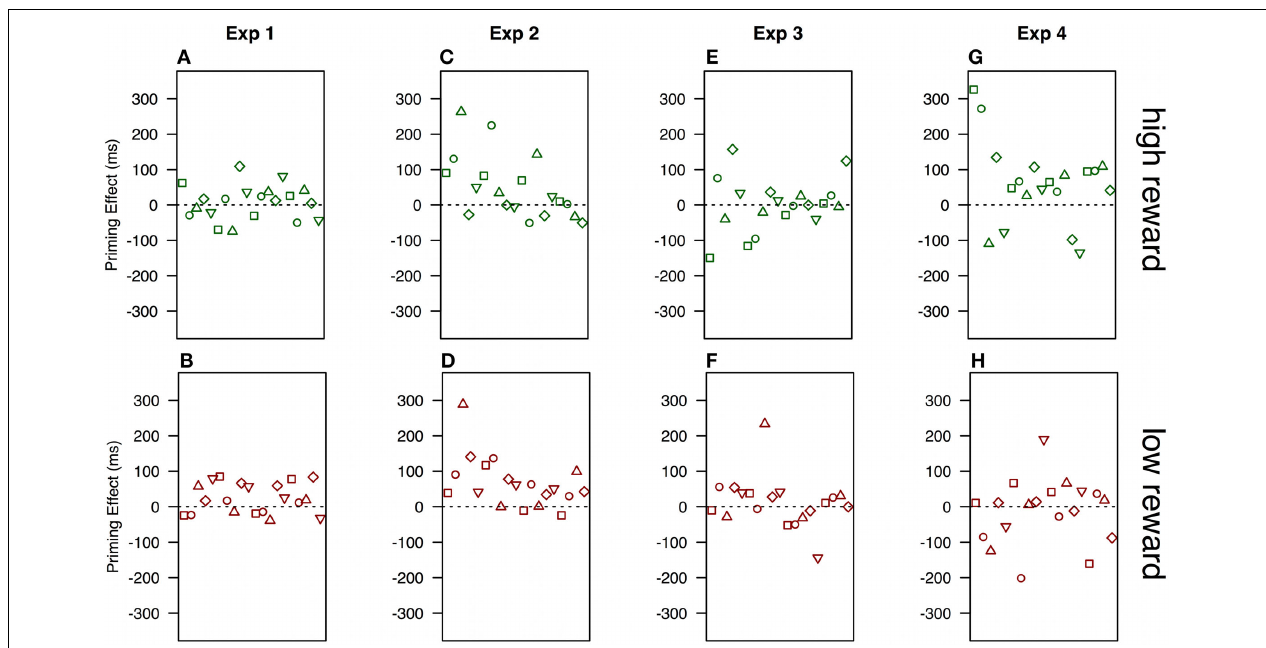
FIGURE 5 | Differences between repeated vs. swapped color displays (RT swap - RT repeated ) when previous reward was high (top panels) and low (bottom panels). Each point represents one observer. The order of observers is maintained within each